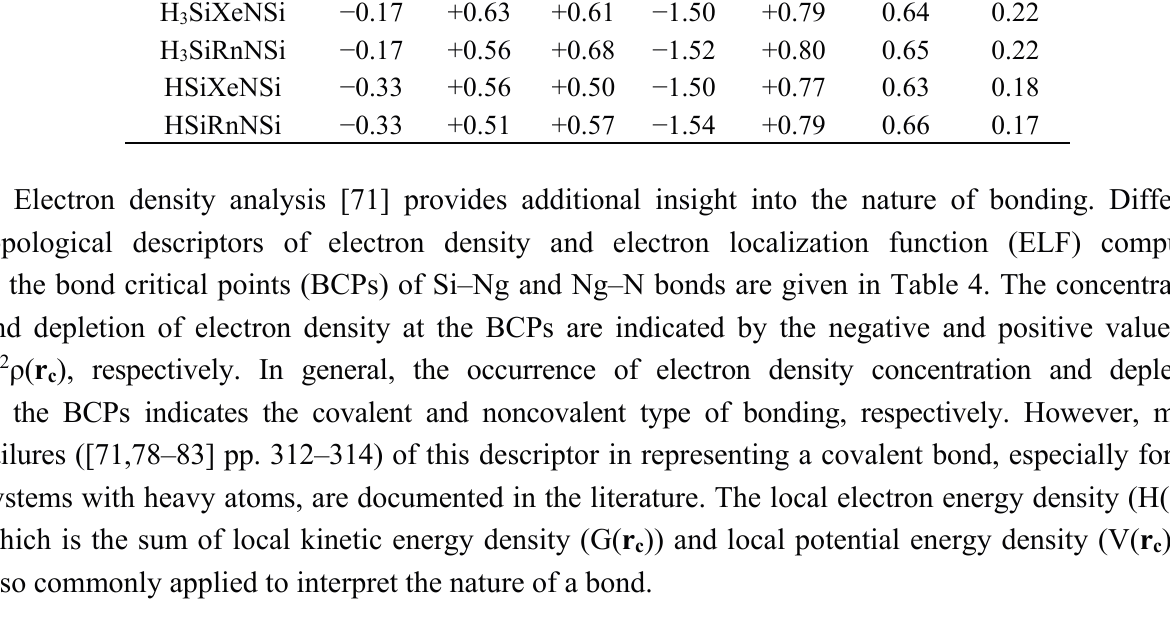
Table 4. Calculated topological properties (au) at the bond critical points of Ng–Si and Ng–N bonds obtained from the .wfn files generated at the MP2/def2-QZVPPD